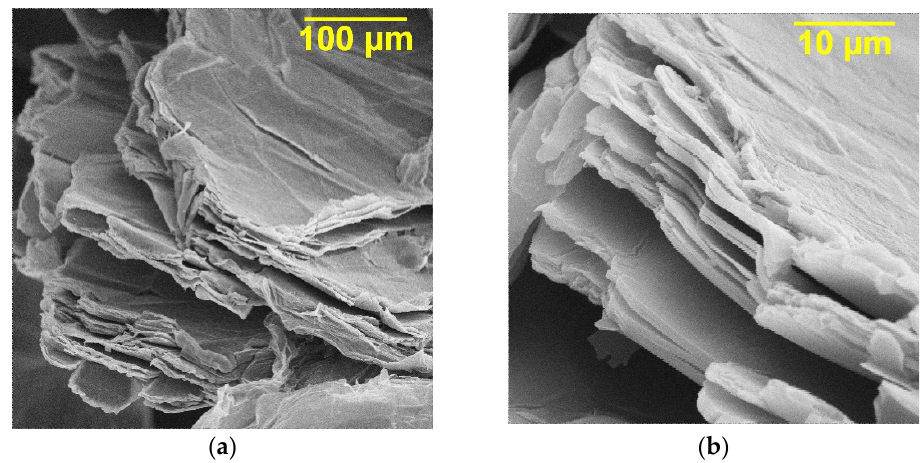
Figure 2. SEM images of the graphene oxide structure. Magnification ×500 ( a ), ×5000 ( b ).